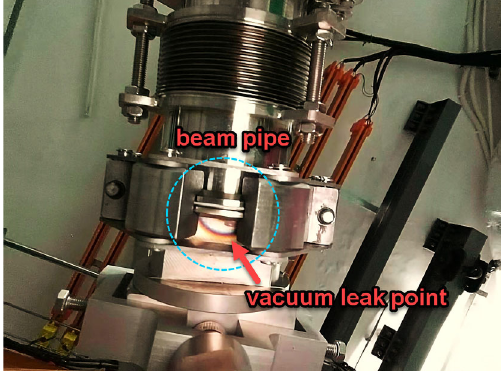
FIG. 5. A beam loss event leading to a vacuum leak accident in